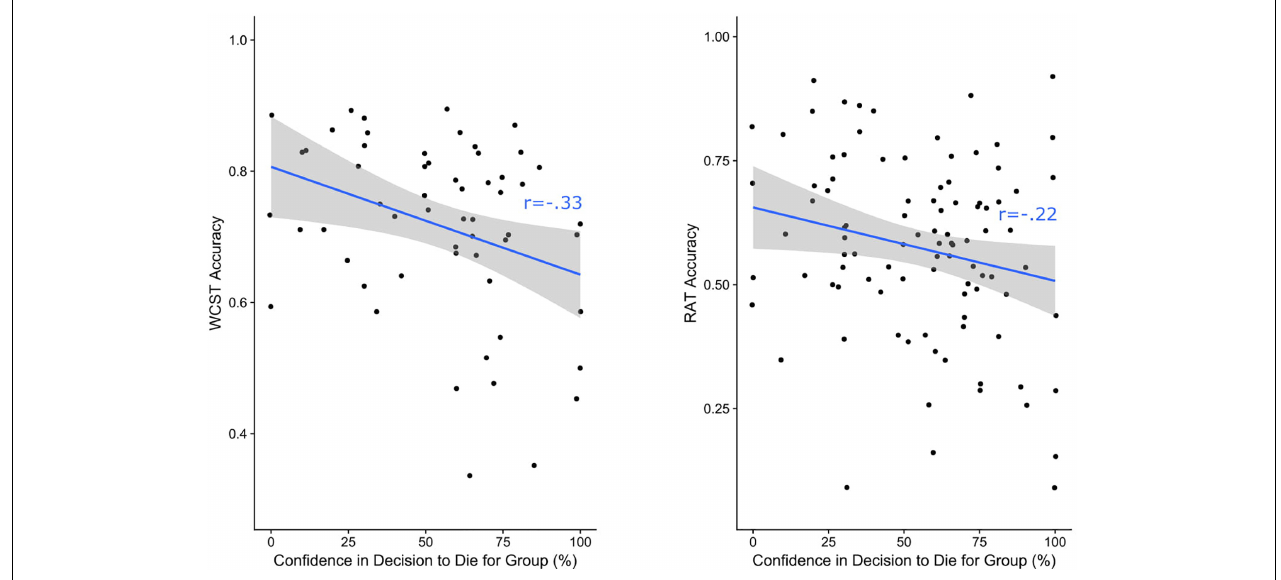
FIGURE 1 | Correlations between cognitive flexibility (WCST and RAT) and participants’ confidence in their decision to sacrifice themselves for the group in a hypothetical ingroup trolley dilemma.